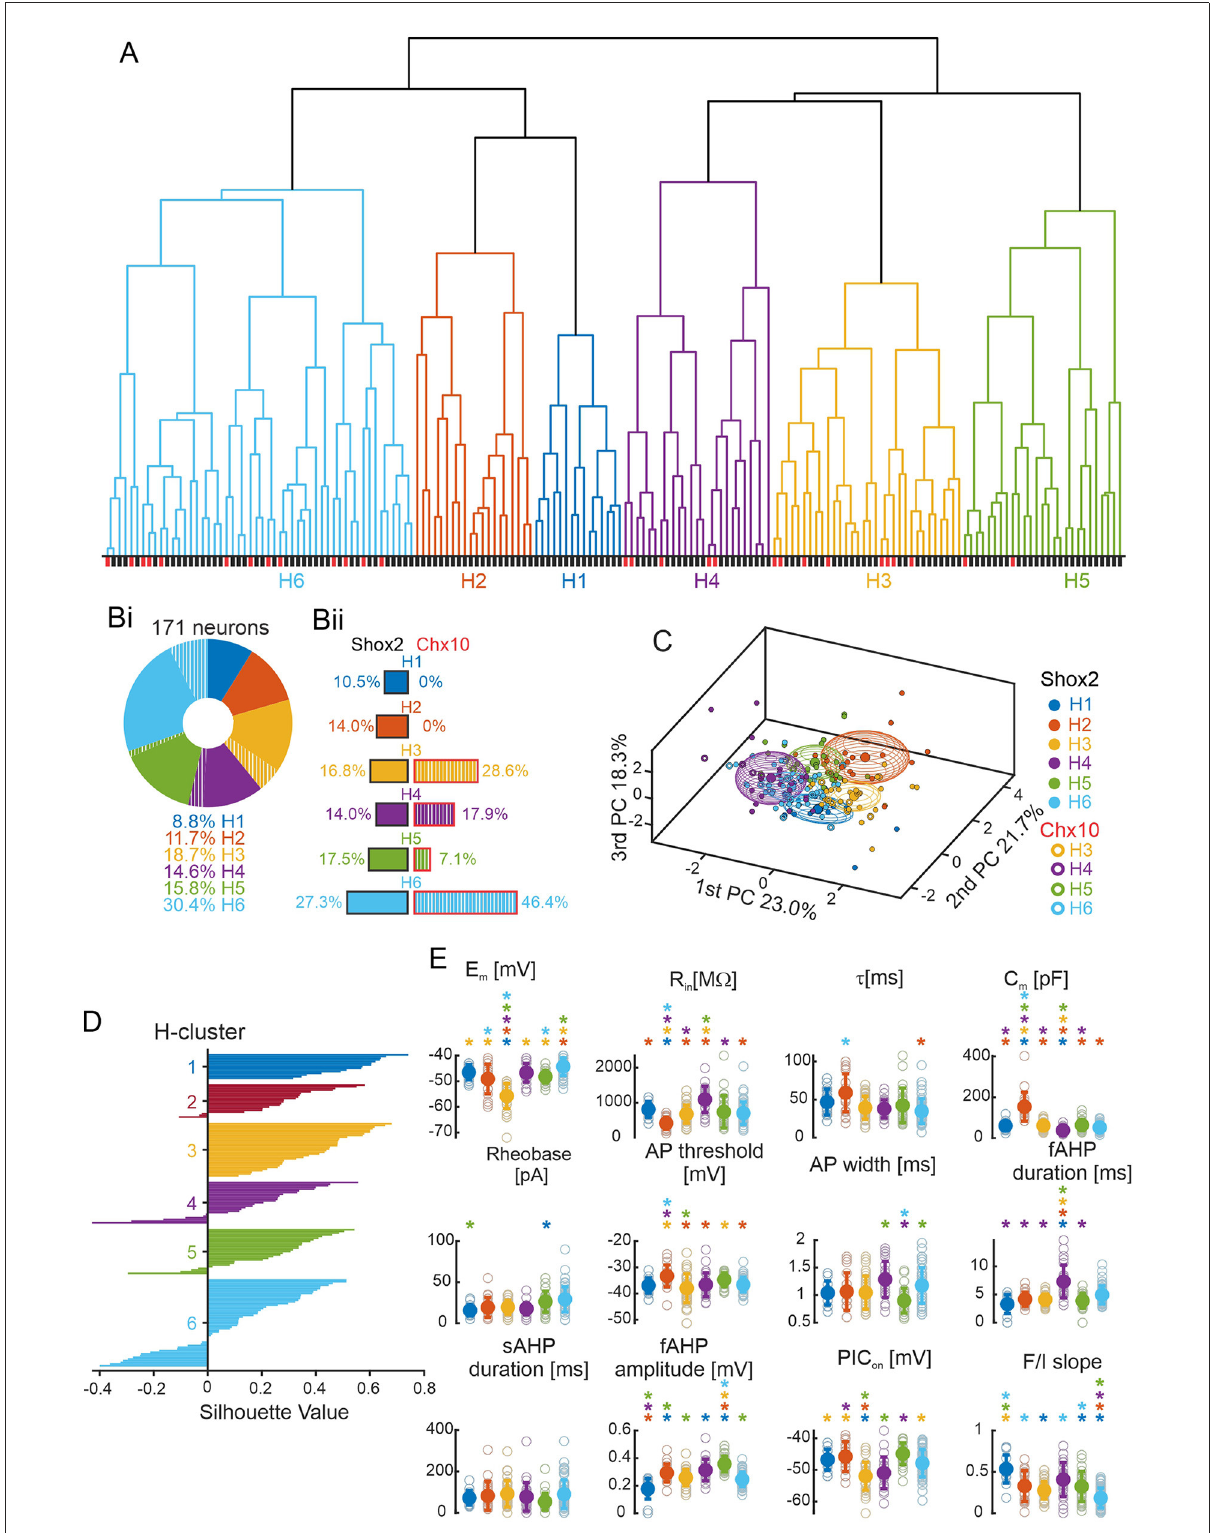
FIGURE6 Hierarchical clustering. (A) Dendrogram plot of the hierarchical binary cluster tree of 171 neurons. Clusters are generated by natural divisions with the cutoff below the value of the maximum inconsistency coefficient. Clusters are color coded: blue for H1 cluster, orange for H2